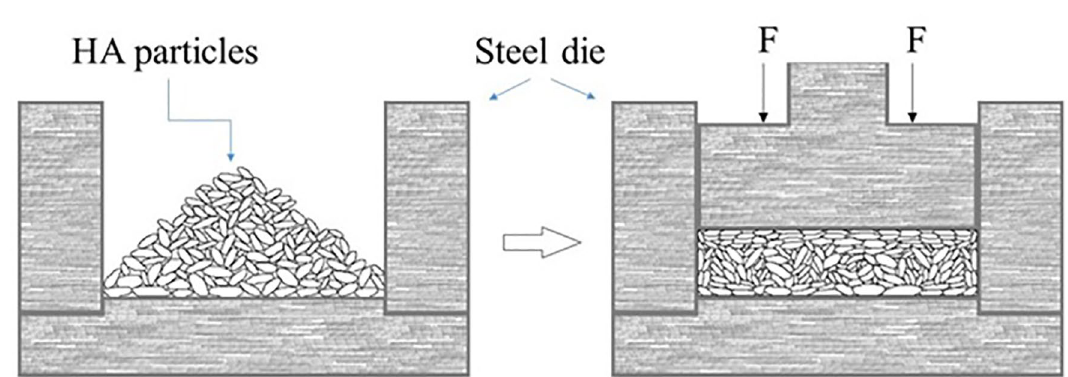
Figure 4. Schematic illustration of the HA particle arrangement after being poured into the steel die (left) and after being pressed (right) into